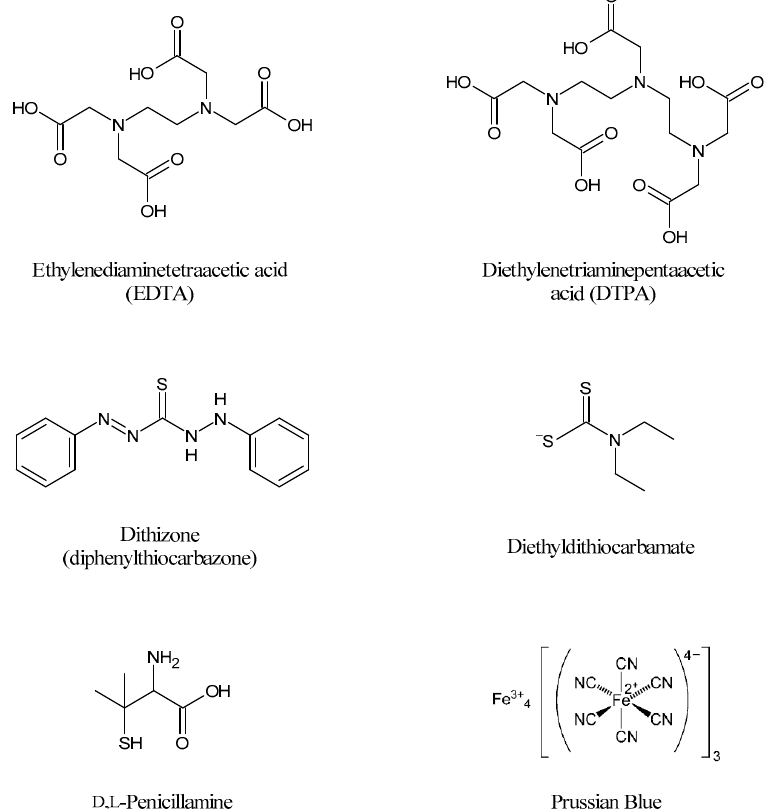
Figure 2. Structures of thallium chelating agents.